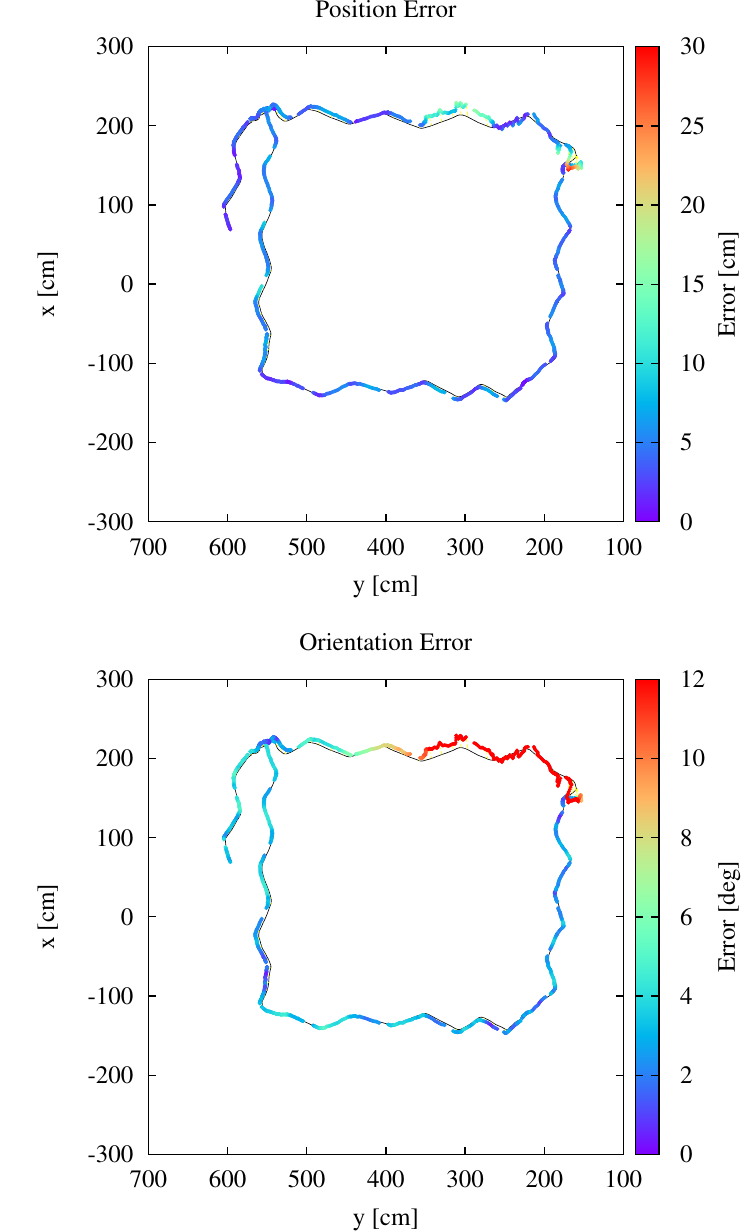
Figure 17. Error for Experiment 2 before optimization. ( Top ): position error. ( Bottom ): orientation